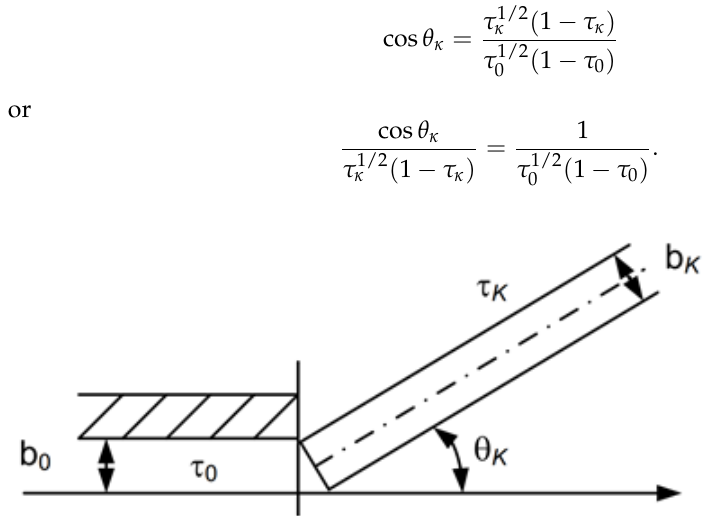
Figure 3. Elementary flow before and after exiting the